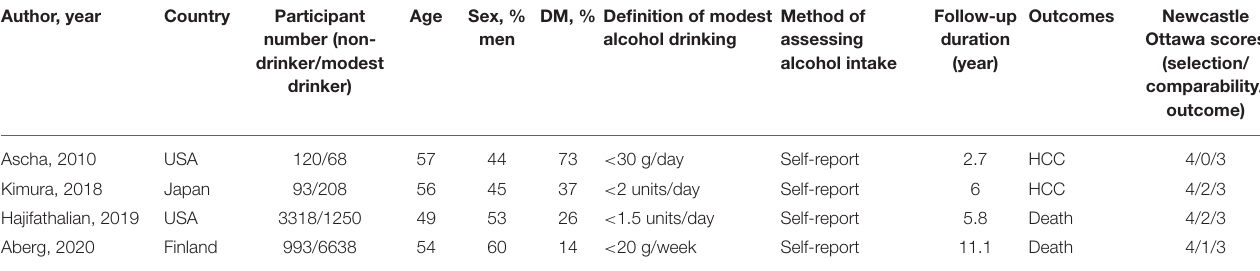
TABLE 1C | Characteristics of cohort studies comparing the risk of major clinical events between non-drinkers and modest drinkers included in the